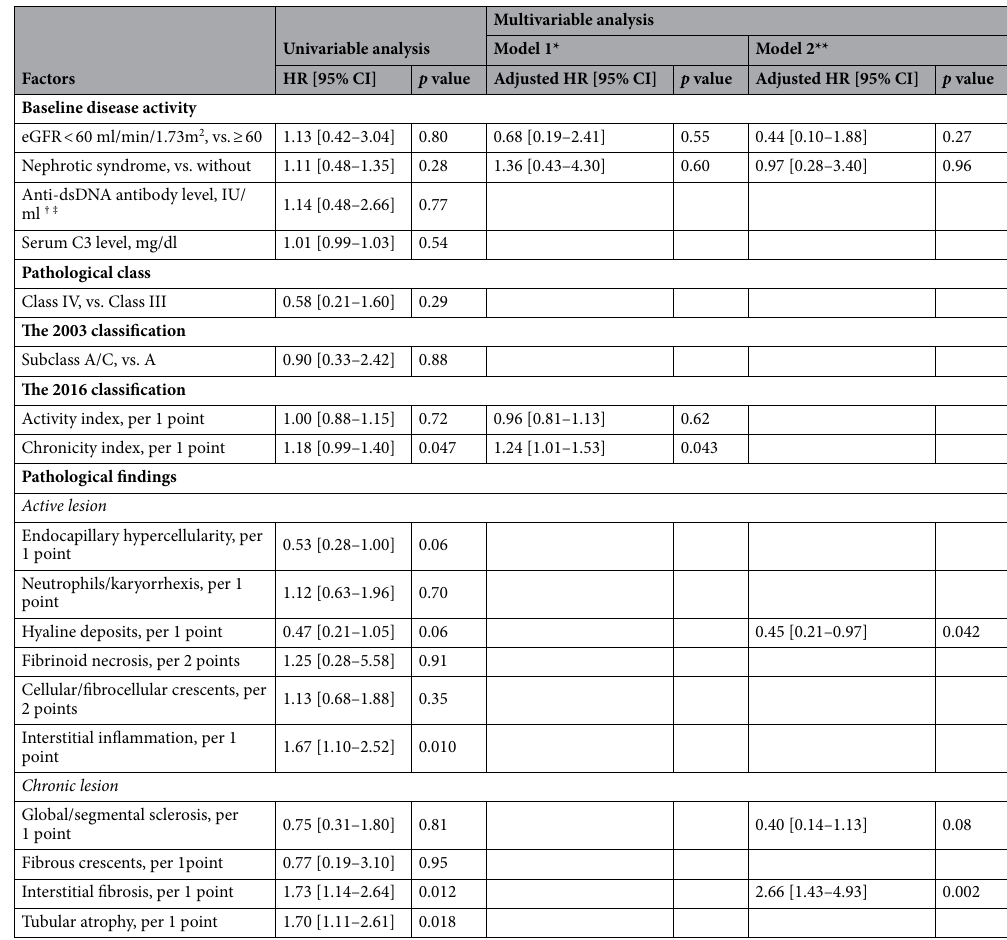
Table 4. Associated factors for renal function decline. eGFR estimated glomerular filtration rate, HR hazard ratio, CI confidence interval. *Model 1 is adjusted by activity index and chronicity index by the baseline eGFR levels (cut-off of 60 ml/min/1.73 m 2 ) and the presence of nephrotic syndrome. **Model 2 is adjusted by pathological components by eGFR and urinary protein levels. Pathological variables associated with 1.5-fold increase in serum creatinine were identified on forward–backward stepwise regression analysis. † Number of missing data: N = 27. ‡